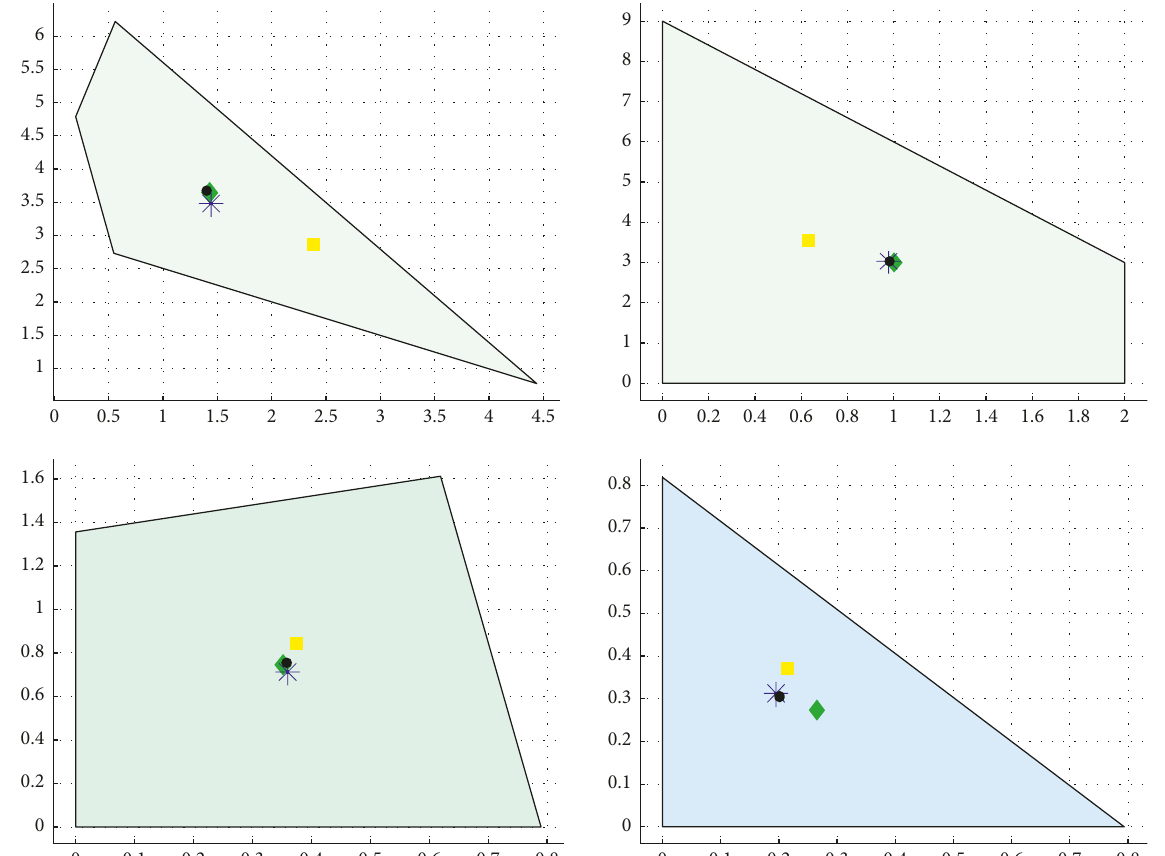
Figure 5: Graphical comparison of quality between analytic center (denoted by yellow square), P-center (denoted by blue asterisk), CN- center (denoted by black dot), and centroid (denoted by green diamond).